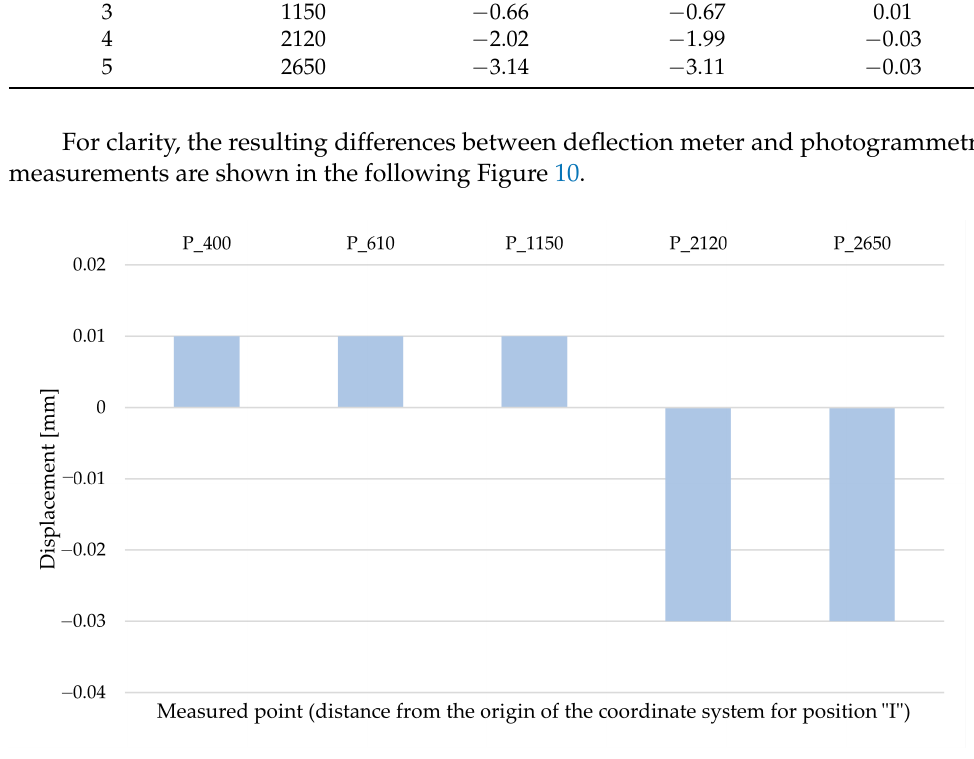
Figure 10. Differences between deflection meter and photogrammetry